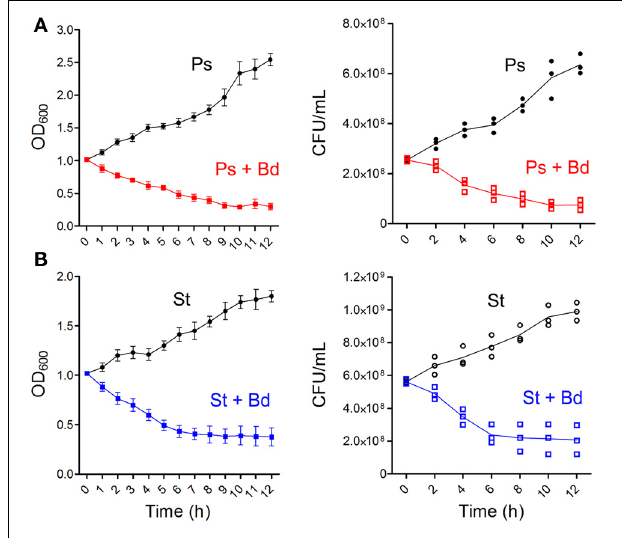
FIGURE 1 | B. bacteriovorus predation on broth cultures of P. aeruginosa and S. aureus . Prey species [ P. aeruginosa , red (A) ; S. aureus , blue (B) ] were grown in TSB till OD 600 = 1, then 2mL of B. bacteriovorus suspension were added to 20mL of culture. Treated and control flasks were in the same incubator at 37 ◦ C and 200rpm. OD 600 measurements were done in triplicate every hour, while CFU/mL counts were done plating 100 µ L of culture (along with serial dilutions) onto TSA plates, leaving colonies to grow overnight at 37 ◦ C.